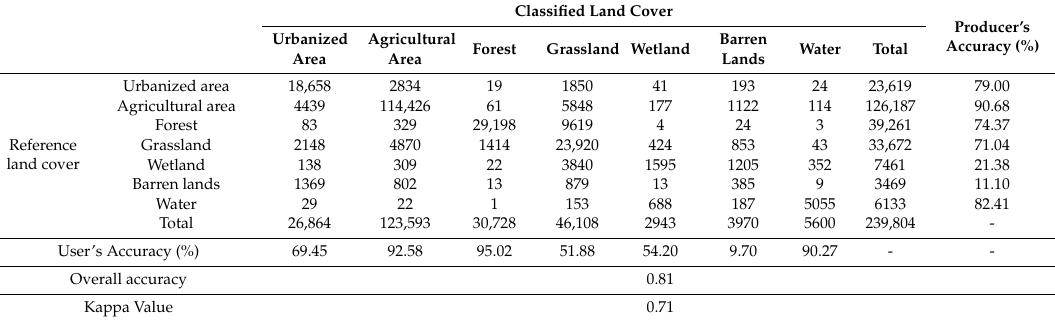
Figure 8. Photos of ( a ) Orthographic image, ( b ) land cover map, and ( c ) classification results of the Subuk-myeon area. Table 2. Accuracy metrics and verification indices for the Subuk-myeon area (unit: 1000 pixels).